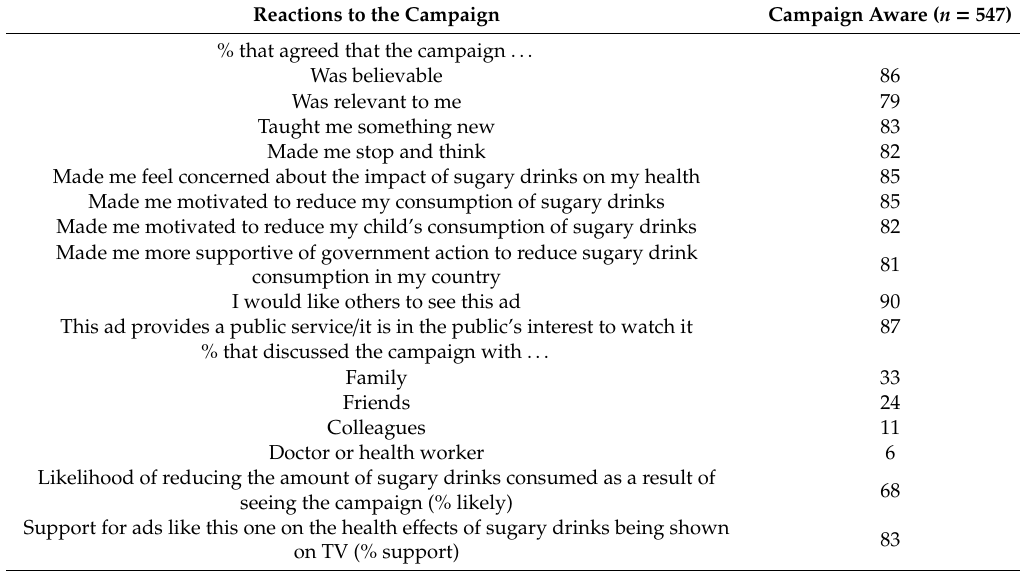
Table 3. Reactions to the campaign among those who recalled it through any medium. Reactions to the Campaign Campaign Aware ( n = 547) % that agreed that the campaign ... Was believable 86 Was relevant to me 79 Taught me something new 83